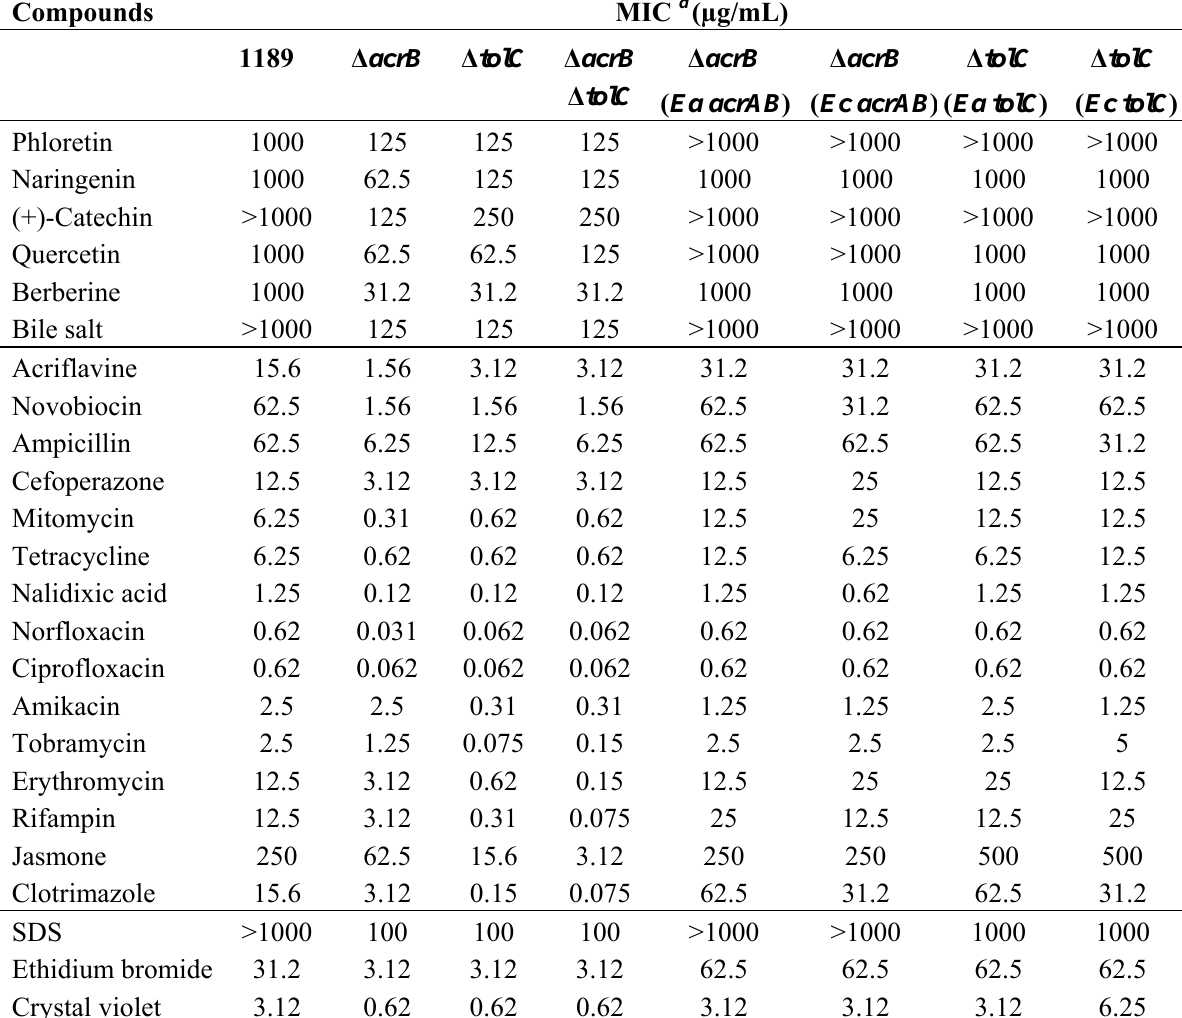
Table 2. Susceptibility of Erwinia amylovora strains to different compounds in complex medium